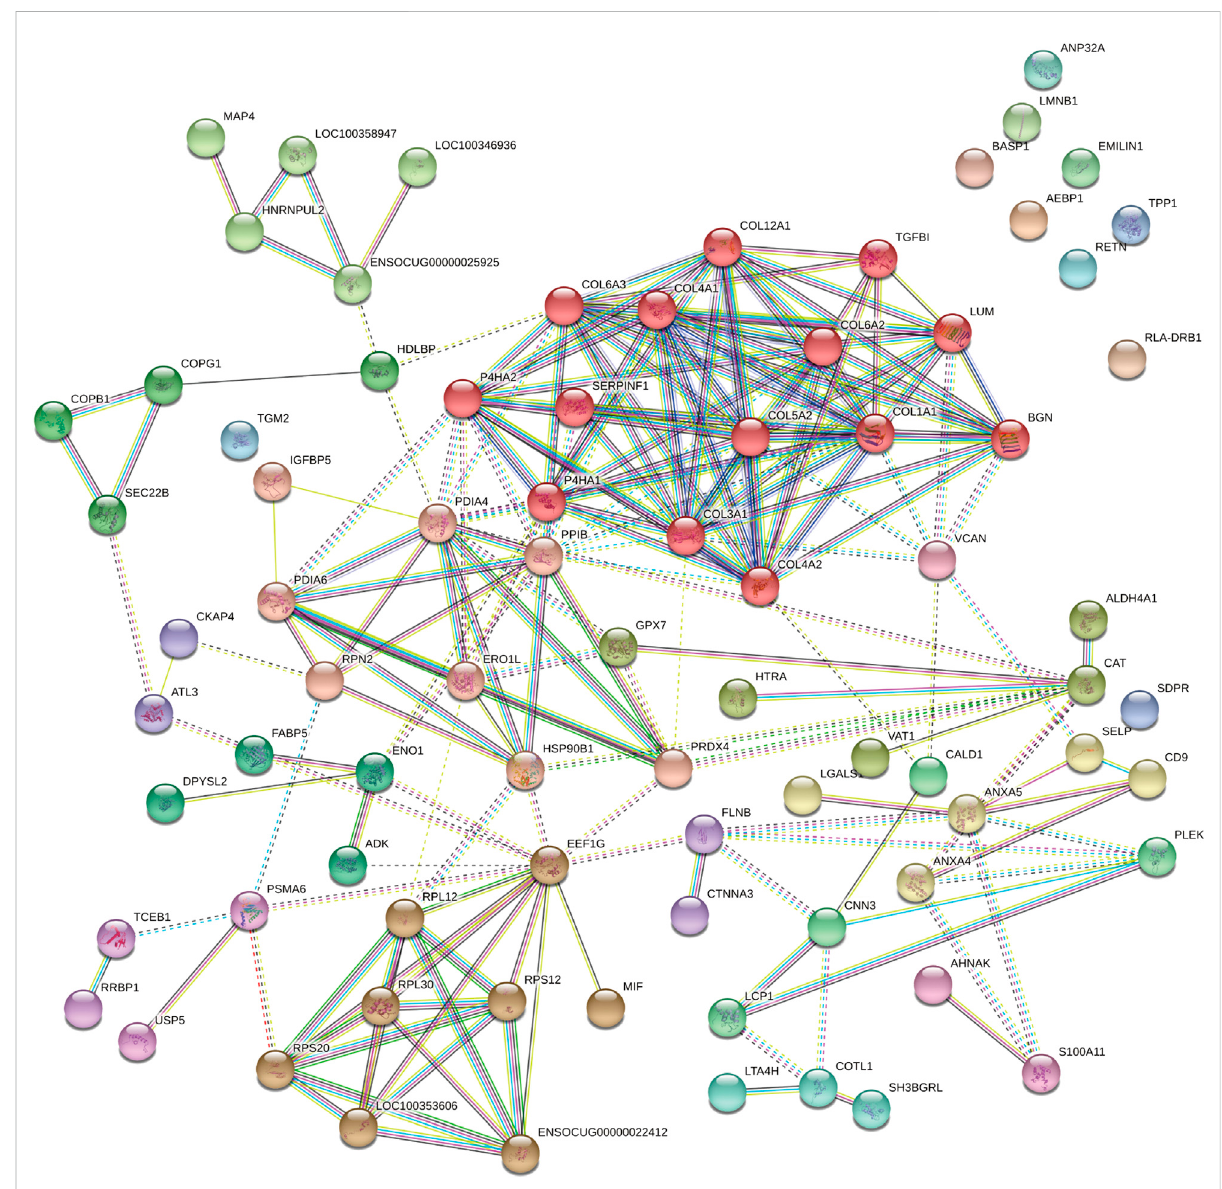
FIGURE 8 The protein-protein interaction network of DAPs analyzed by the STRING software. Each note represents a protein and lines represent interactions. DAPs: differentially expressed proteins.